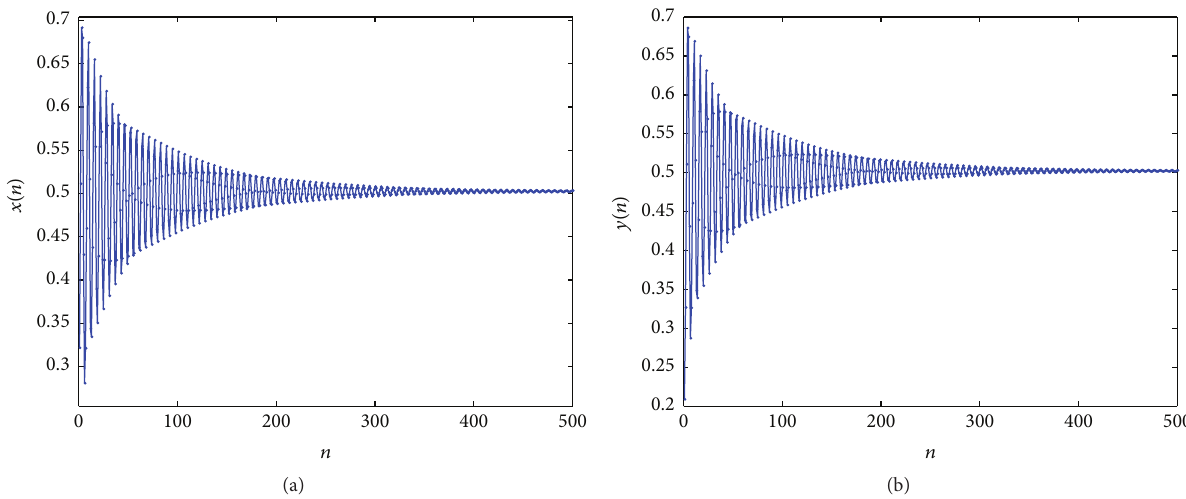
Figure 3: Time history diagram of the controlled delayed species model (14) for 𝑘 2 = −0.03 and 𝑟 = 2.01 . The initial values are [𝑥(0) = 0.2,𝑦(0) = 0.2]